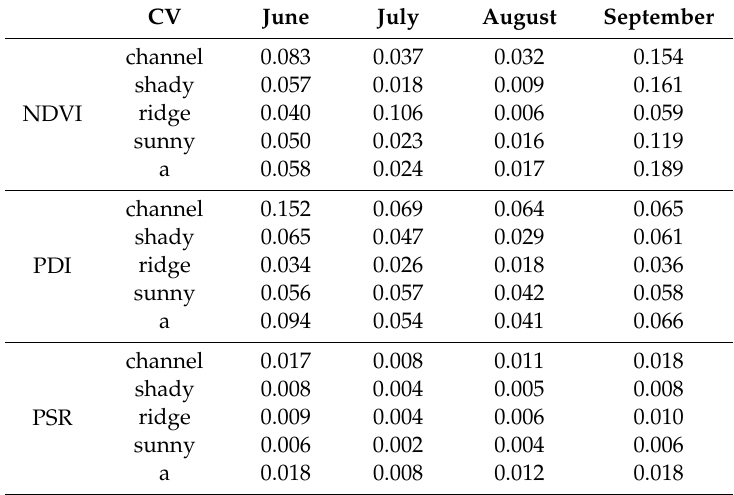
Figure 6. Daily average temperature and rainfall in the study area. (( a – d ) represent the rainfall and temperature in June, July, August and September, respectively.) Table 4. Statistical table of coe ffi cient of variation (CV) of normalized di ff erential vegetation index (NDVI), perpendicular drought index (PDI) and potential solar radiation